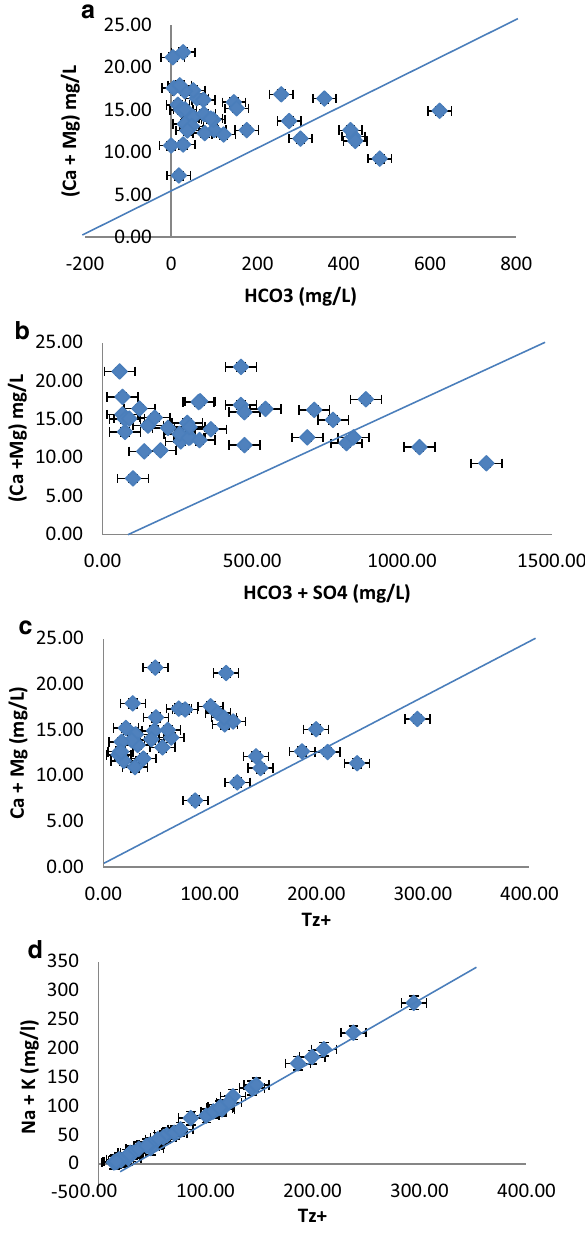
Fig. 3 Bivariate plots of some chemical data of the groundwater sam- ples from the study